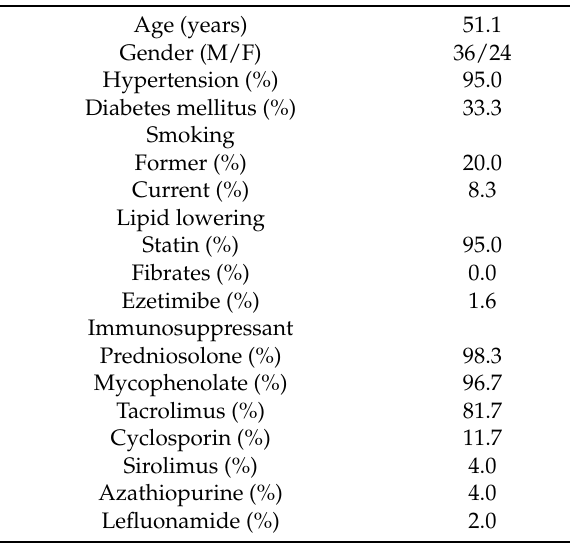
Table 2. Sociodemographic, laboratory and clinical characteristics of 60 kidney transplant